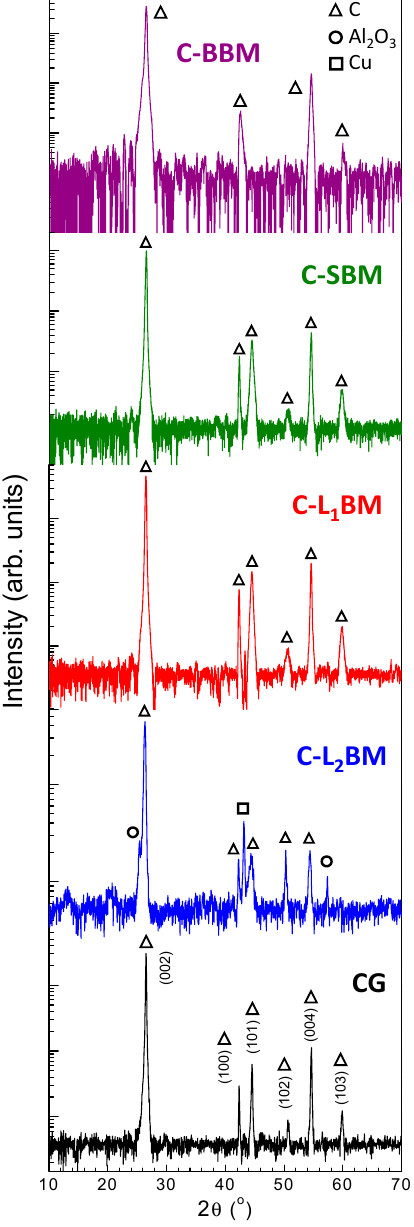
Figure 1. XRD patterns of the obtained final solids. In all cases, the more intense diffraction maxima were indexed to the carbon-graphite phase with hexagonal structure and space group P6 3 /mmc (JCPDS 00-056-0159). The nar- rower and higher peak centered at around 26.5° can be attributed to the reflection in the (002) plane of aromatic layers. Other peaks centered at 42°, 44°, and 54°, which correspond to the (100), (101), and (004) planes of graphite carbon, can also be observed. The (002) peak is attributed to the orientation of the aromatic ring carbon reticulated layers in three- dimensional arrangement. The (100) peak is related to the degree of condensation of the aromatic ring (i.e., the size of the carbon slice of the aromatic layer [19]). The sharper and the higher the (002) and (100) peaks are, the better the orientation and the larger the size of the aromatic layer slice, respectively. A comparative analysis of the structural data of the final obtained materials is sum- marized in Table 3. In all cases, the calculated d 002 of the recycled graphites were very similar to that of ideal graphite (0.3354 nm) with d 002 values < 0.3440 nm. Therefore, they